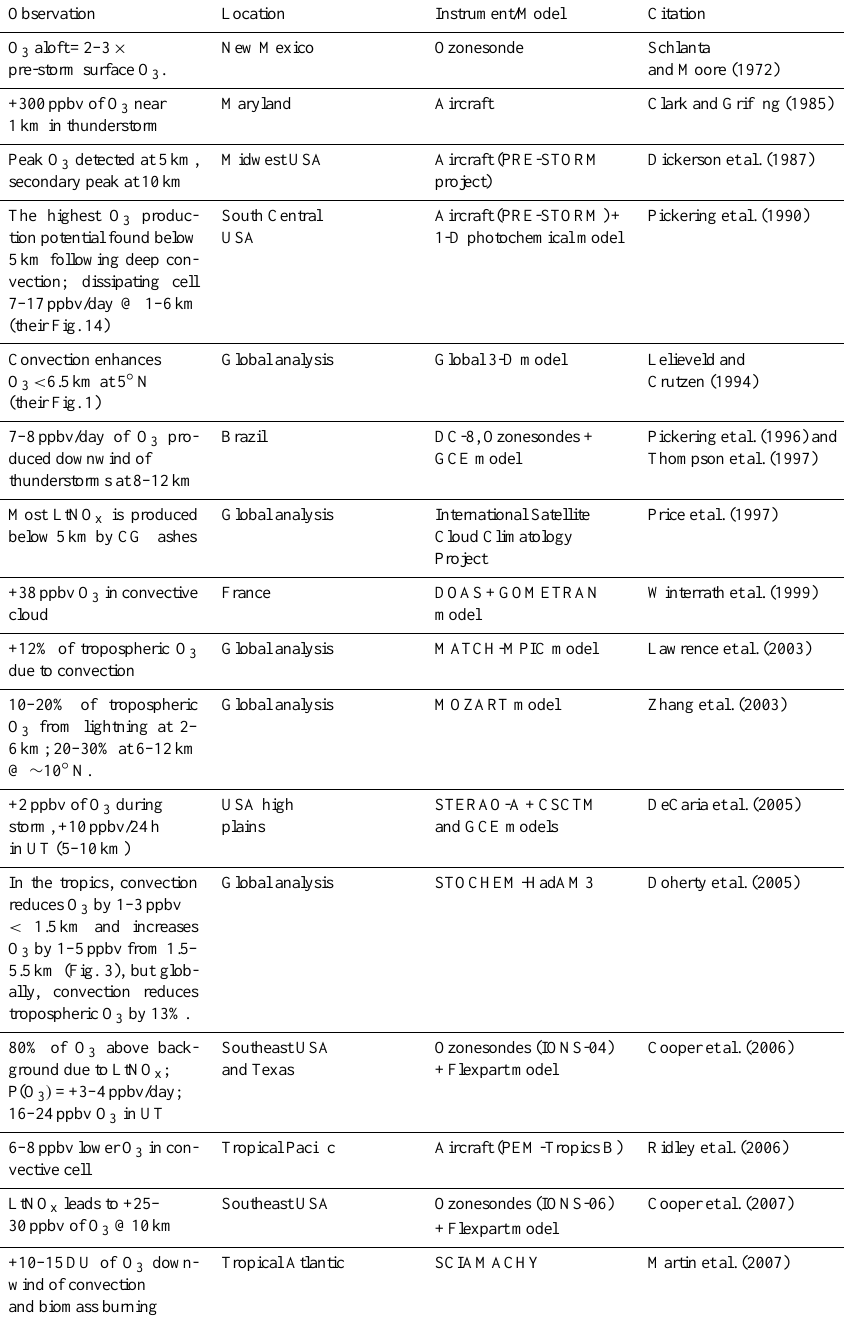
Table 1. Summary of previous studies of O 3 production. Observation Location Instrument/Model